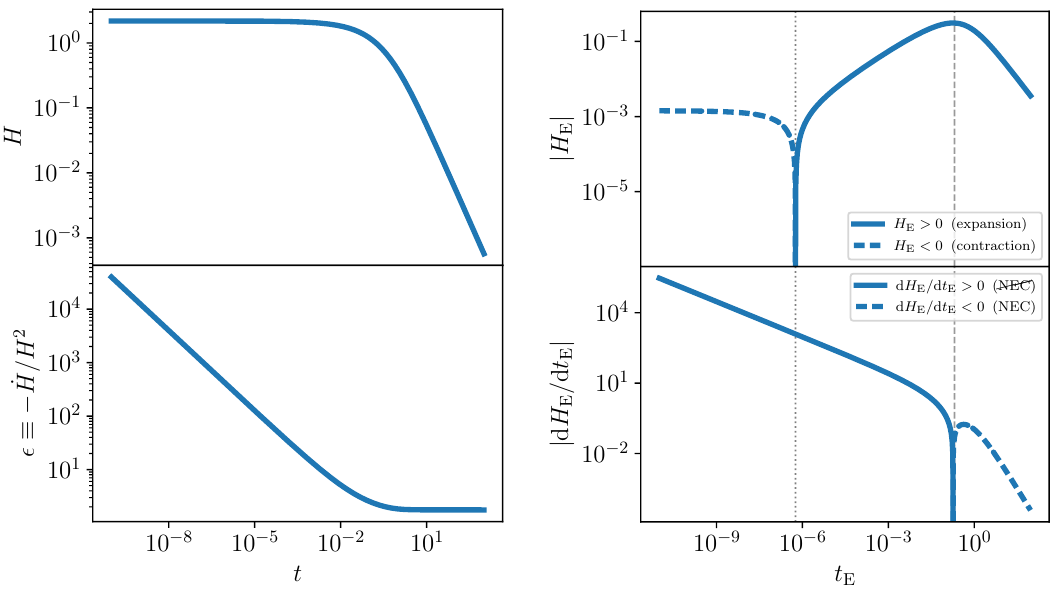
Figure 5 . Numerical solution in the string frame (left plots) and in the Einstein frame (right plots) corresponding to the blue dashed trajectory in figure 4. The vertical dashed line in the right plots marks the separation between satisfying the NEC and violating it ( (cid:24)(cid:24) line denotes the bouncing